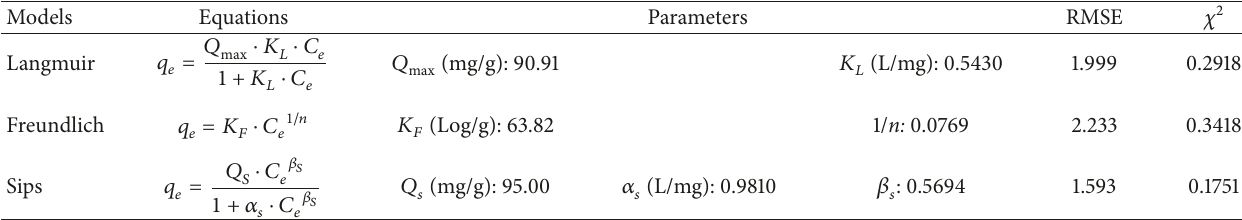
Table 1: Isotherm equilibrium parameters calculated from different models.